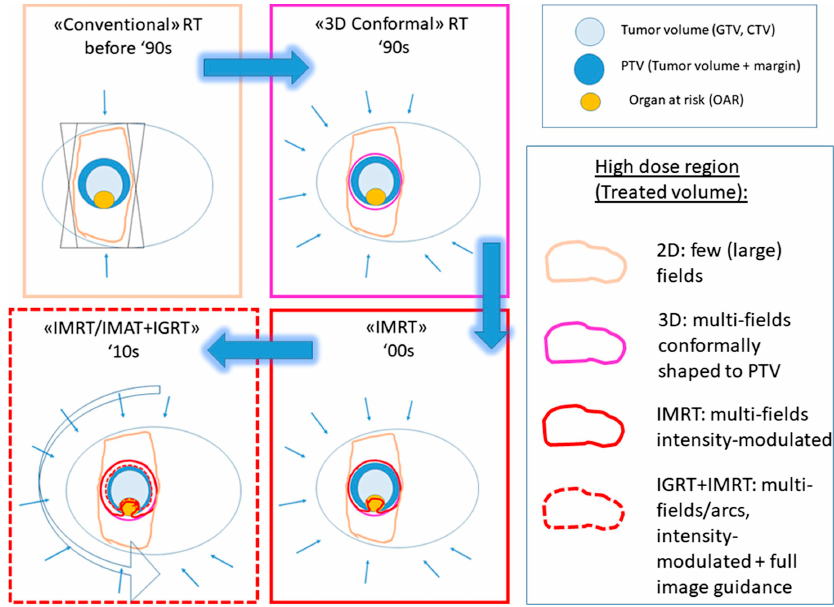
Figure 2. Scheme of a PTV next to healthy tissue treated with different radiotherapy treatments to represent the evolution of dose delivery in radiotherapy over the last 25 years. (Reproduced with permission from reference [4]). CTV: clinical target volume; GTV: gross target volume; IGRT: im- age guided radiotherapy; IMAT: intensity modulated arch therapy; IMRT: intensity modulated radiotherapy; PTV: planning target volume; RT: